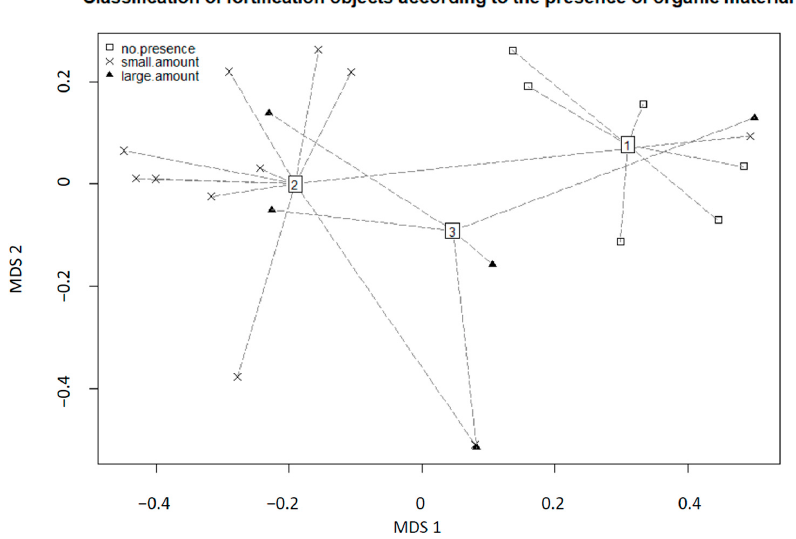
Figure 6. Ordination diagram (MDS) showing the distribution of individual SA ‐ CEFs depending on the presence of organic material (land snails, for all SA ‐ CEFs, without data adjustment).